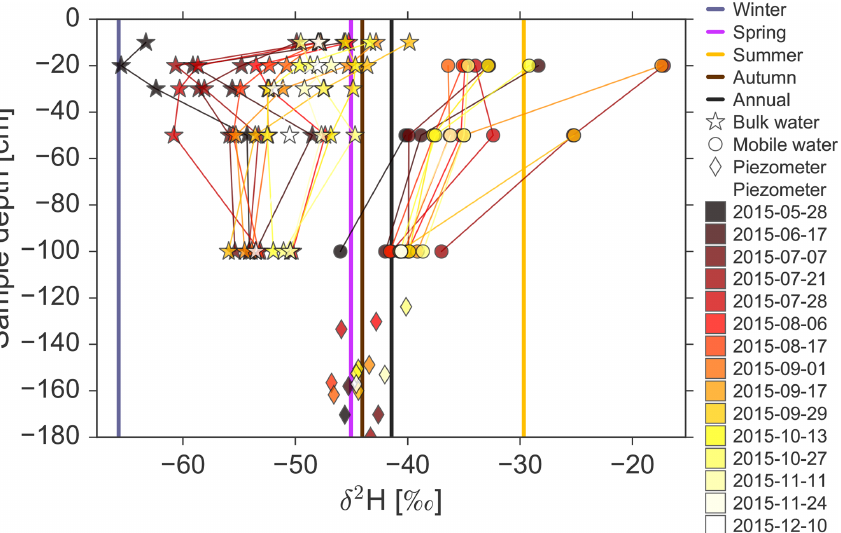
Figure 3. Depth profiles showing the variability of the stable isotopic composition across the soil profile over the sampling period (color coded) for bulk soil water (stars), mobile soil water (circles), and groundwater sampled from the piezometer (diamonds). Vertical lines represent seasonal and annual weighted averages of precipitation. Location of the piezometer samples according to the depth of the water table in the piezometer.